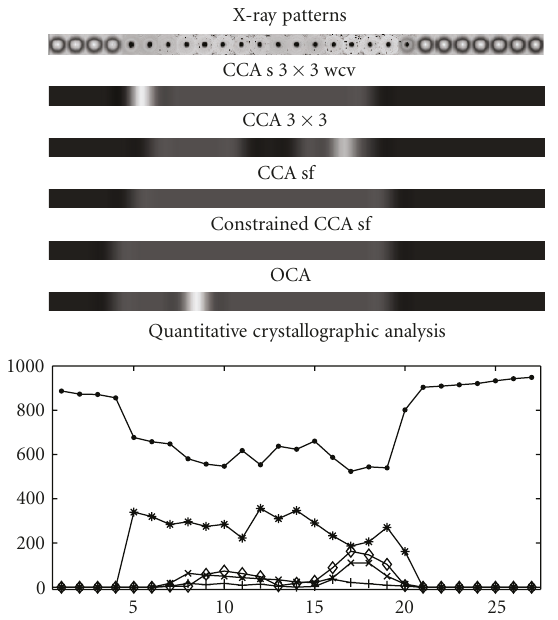
Figure 6: Top: cross-section from top to bottom of Figure 1 along the 11th column from left. Middle: the corresponding cross- sections of the di ff erent CCA maps of Figure 5 (black: amorphous, light gray: hydroxya (micro), gray: Tcp ( α ), dark gray: hydroxya (nano)). Bottom: quantitative crystallographic analysis ( • : amor- phous, ∗ : hydroxya (nano), (cid:2) : Tcp( α ), × : hydroxya (micro), +: Tcp( β )).